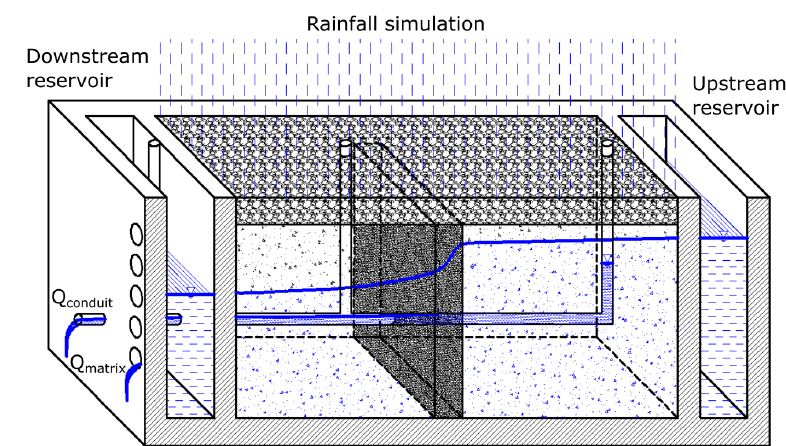
Figure 7. Scheme of the physical model.